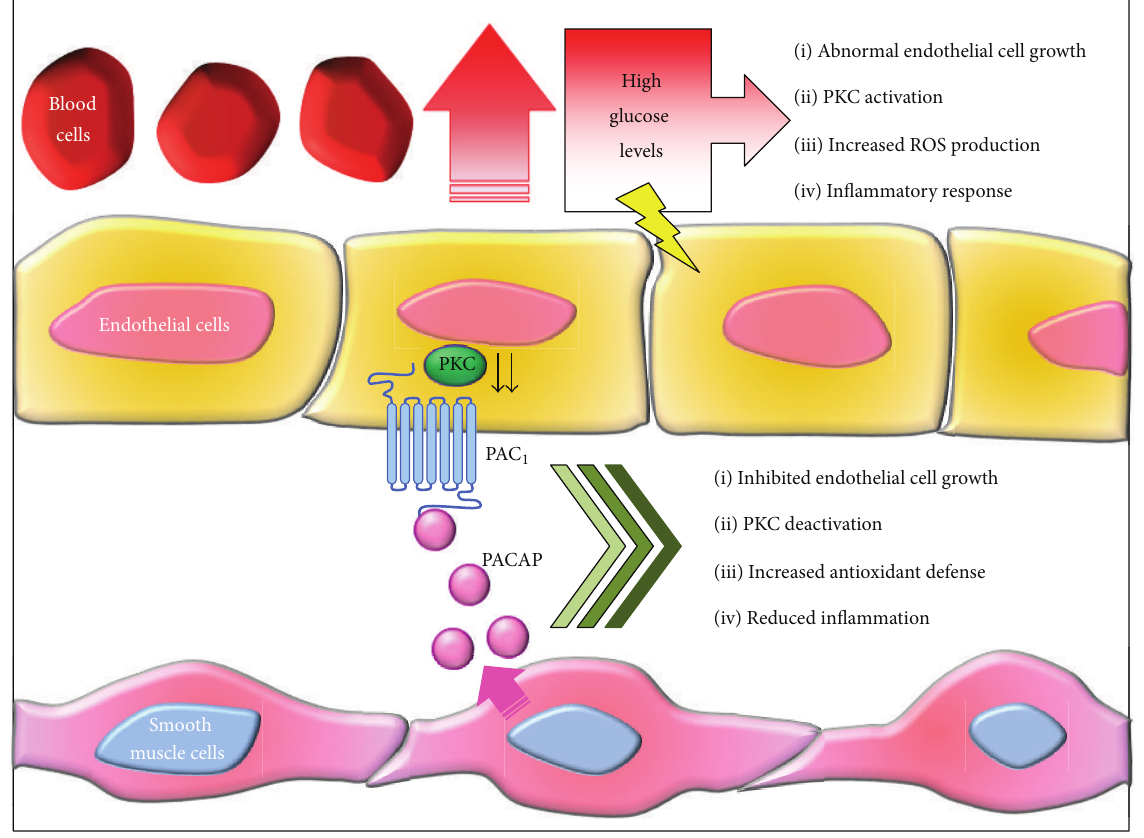
Figure 3: Proposed model depicting the ameliorative role of PACAP in hyperglycemia-induced endothelial dysfunction: potential involvement of smooth muscle cells through a paracrine mechanism. One of the most devastating complications of persistent hyperglycemia is micro- and macroangiopathy that may determine abnormal vasculogenesis. However, the exact pathogenetic mechanisms are still not well understood. In the proposed scenario, longstanding high glucose levels in the blood stream cause both mechanical (shear stress) or oxidative injury ( ↑ ROS production) to endothelial cells, whose in turn react by triggering local inflammatory responses, sustained PKC activation, and aberrant angiogenesis ( ↑ endothelial cell proliferation). PACAP seems to play a homeostatic role in this process. Once released by the neighboring smooth muscle cells (SMCs) it binds to PAC1 receptors expressed by both endothelial cells and SMCs, thereby activating a cAMP-driven signalling cascade that inhibits glucose-induced proliferation of both cell populations and ROS production and dampens PKC function as well as local release of proinflammatory cytokines by infiltrating